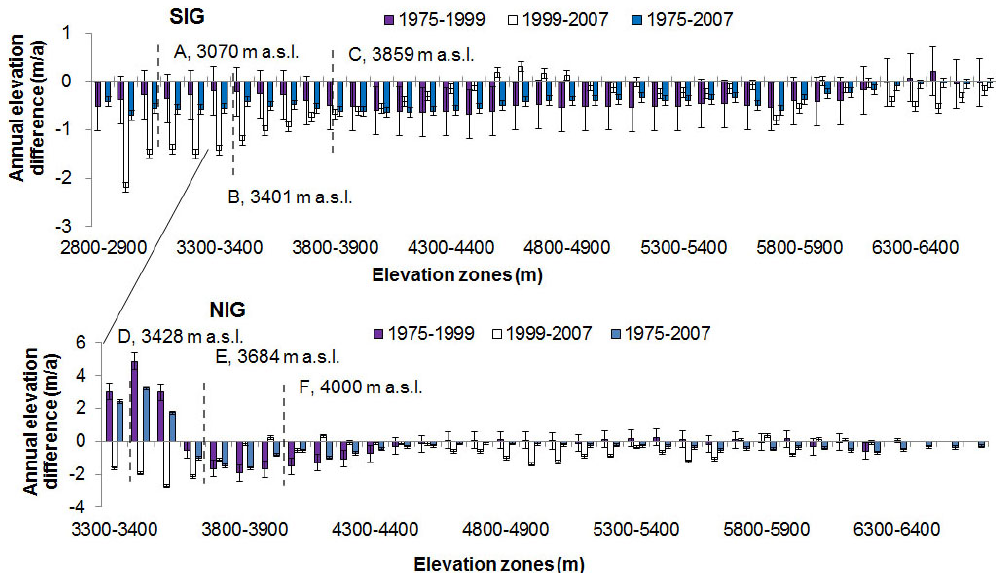
Figure 6. The mean annual elevation difference measured for the periods of ∼ 1975–1999 (KH-9–SRTM), 1999–2007 (SRTM–SPOT) and ∼ 1975–2007 (KH-9–SPOT) along the elevation zones in the SIG and NIG. For SIG, the elevation difference in zones 2800–3000 was derived from KH-9–ALOS between ∼ 1975 and